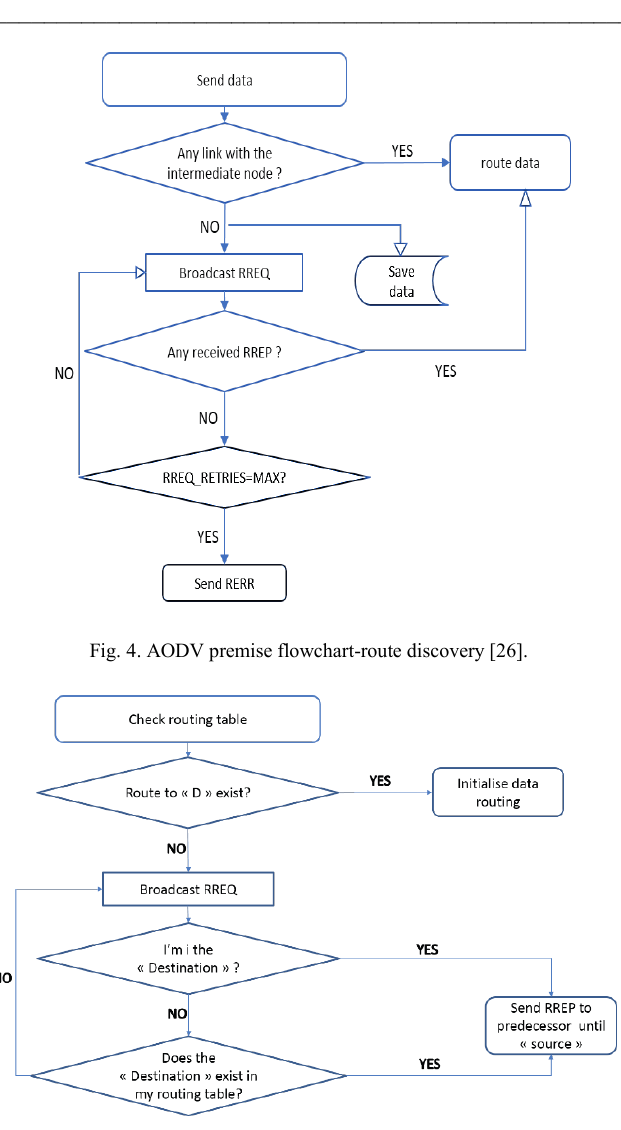
Fig. 5. AODV premise flowchart-route maintenance. Table I resumes advantages and limitations of routing protocols based on topology in VANETs. TABLE